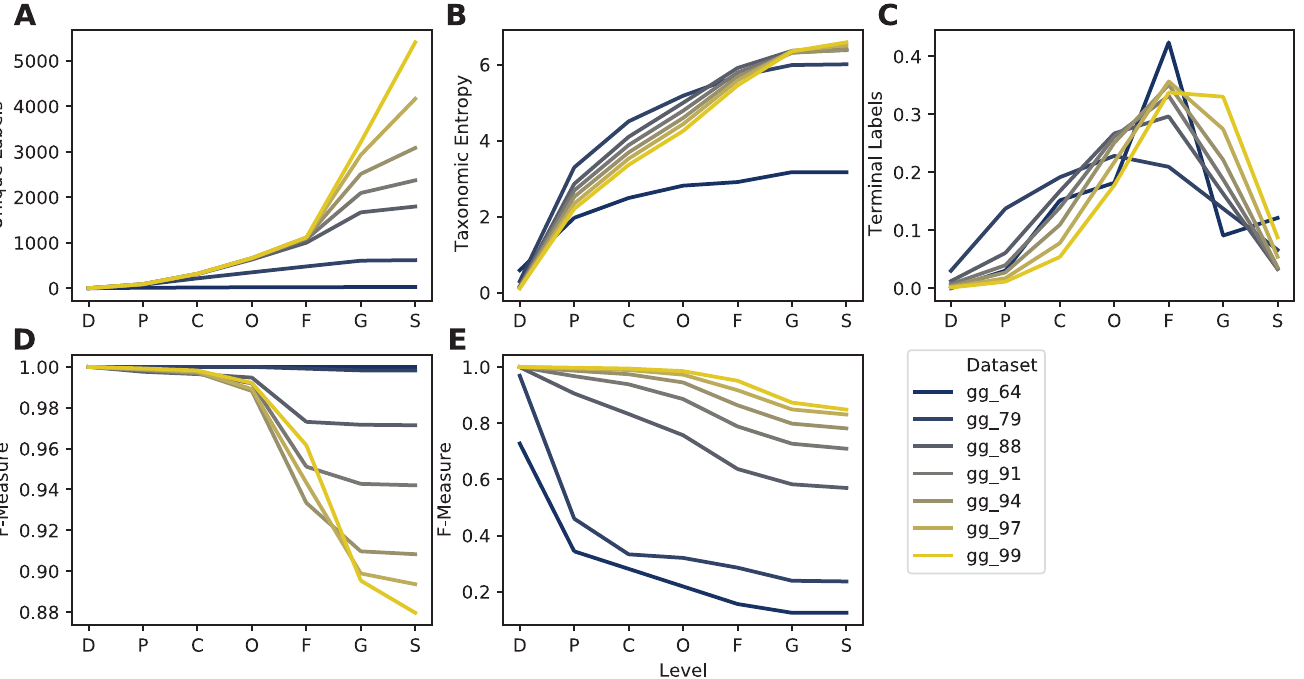
Fig 8. Taxonomic information (A-C) and classification accuracy (D-E) of Greengenes 16S rRNA gene database clustered at different similarity thresholds. Subpanels show taxonomic/classification characteristics at each taxonomic level: A, Number of unique taxonomic labels; B, Taxonomic entropy; C, number of taxa that terminate at that level; D, optimal classification accuracy (as F-Measure) without cross-validation (simulating best possible classification accuracy when the true label is known but classification accuracy may be confounded by other similar hits in the database); E, classification accuracy (F-Measure) with cross-validation (simulating realistic classification tasks when the correct label is unknown). Rank labels on x-axis: D = domain, P = phylum, C = class, O = order, F = family, G = genus, S = species.